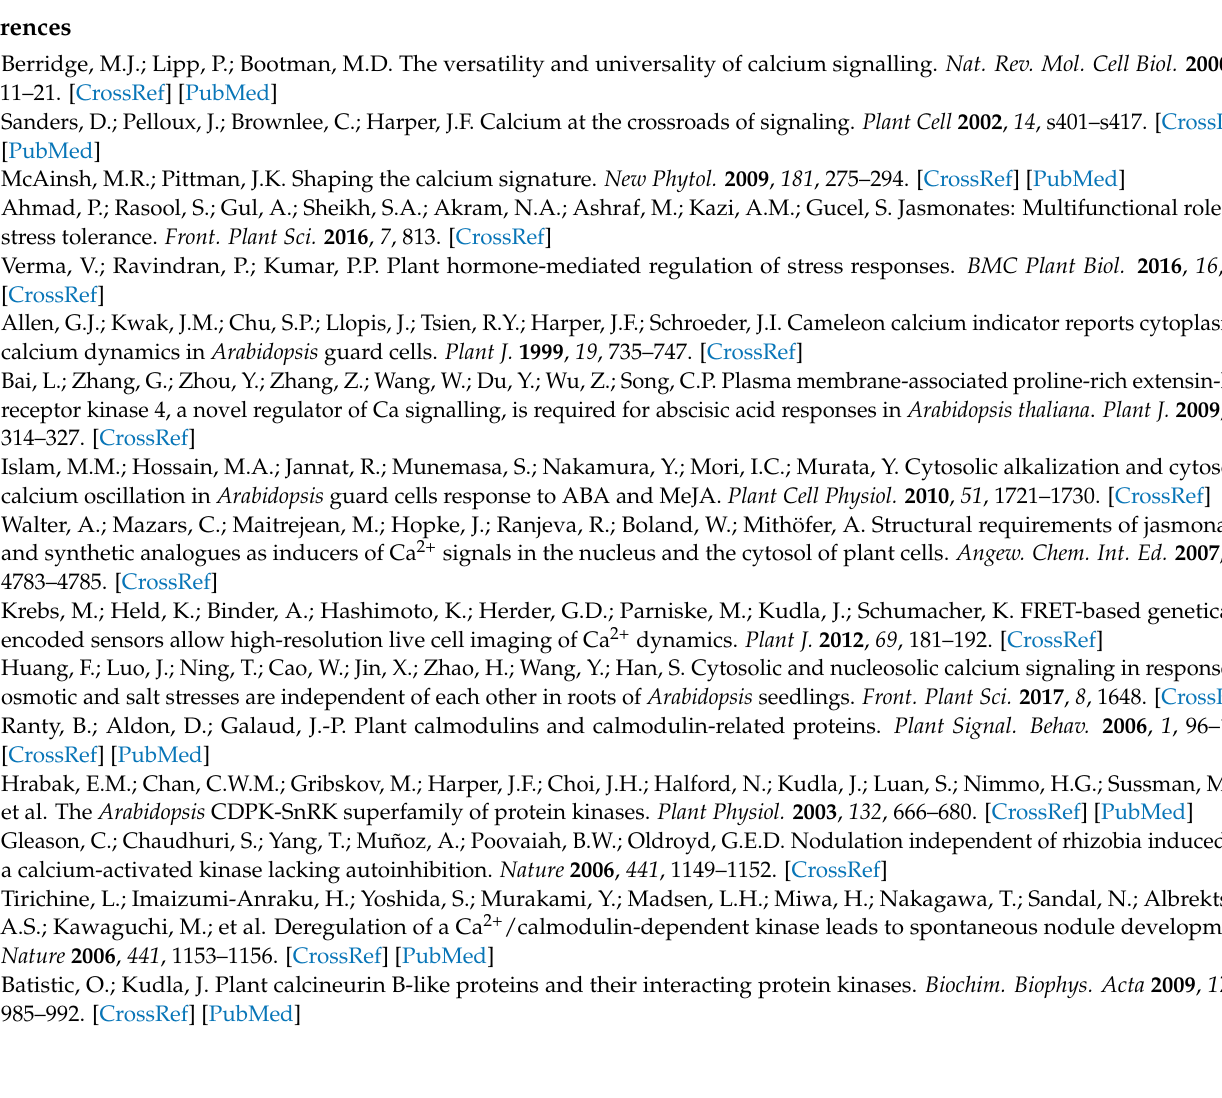
responsive genes, Table S3: [Ca 2+ ]-regulated JA-responsive genes, Table S4: Microarray datasets used for the construction of co-expression networks, Table S5: Decoding Ca 2+ signalling proteins, Table S6: Hormone signalling pathway proteins, Table S7: Genes in the co-expression network, Table S8: Genes co-expressed with CAM1 , CIPK8 , GAD1 , and GUN5